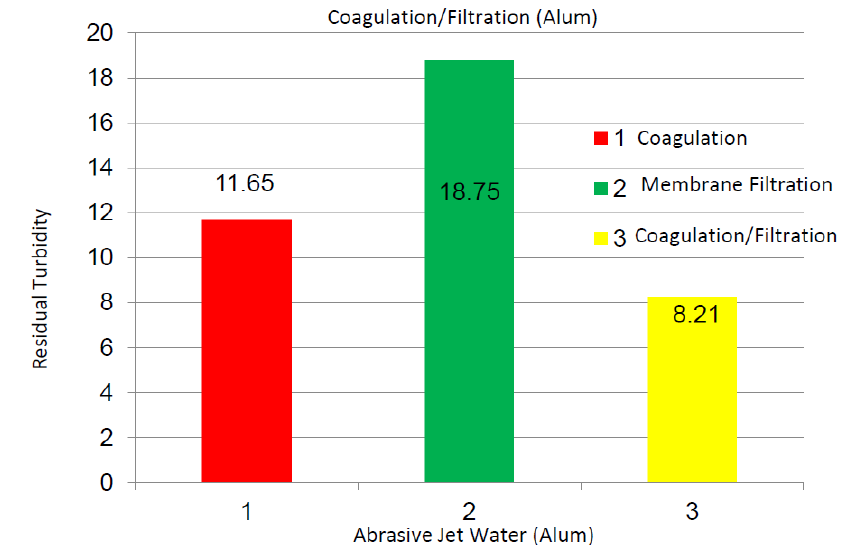
Figure 8. Turbidity values of abrasive jet water using Alum coagulation, membrane filtration, and coagulation + filtration processes; coagulation tests conducted using 50 mg/L Alum after 1 h of settlement in